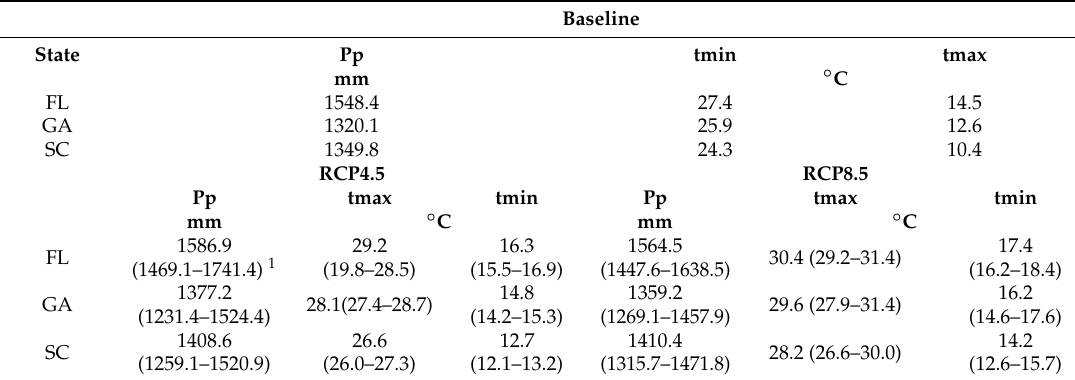
Table 1. Average precipitation (Pp), maximum and minimum temperatures (tmax, tmin) for all climatic